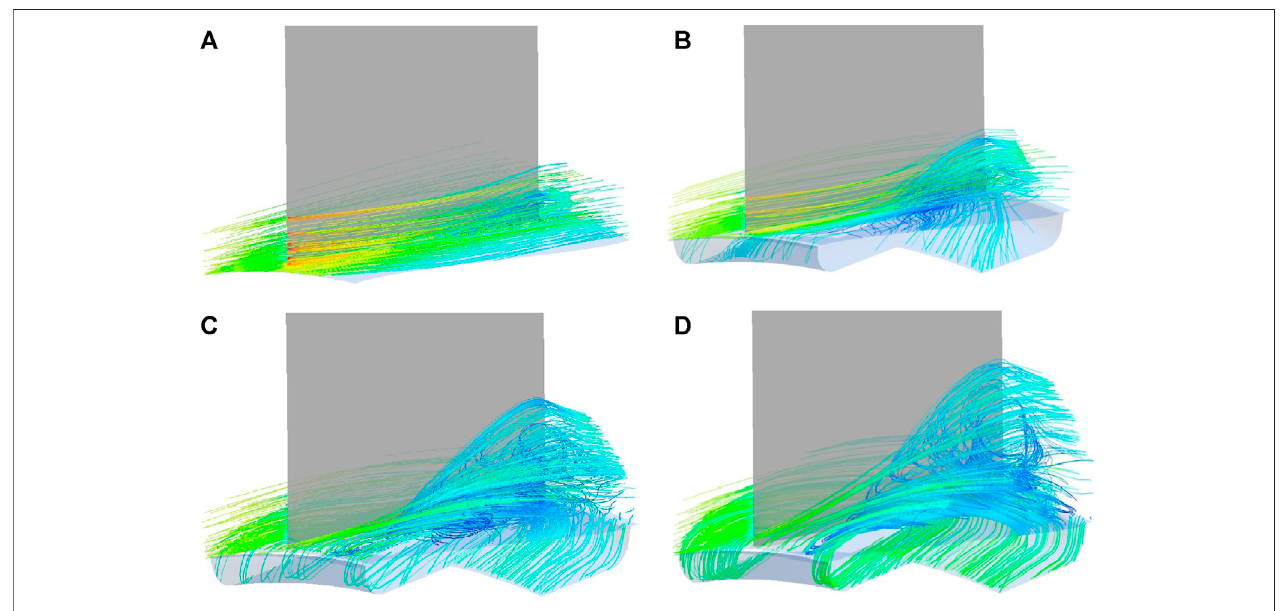
FIGURE 13 | 3D streamlines near the root region of S3 at the nearest stall point of 75%n. CASE 0% (A) , CASE 0.3% (B) , CASE 0.5% (C) , CASE 0.7% (D) .